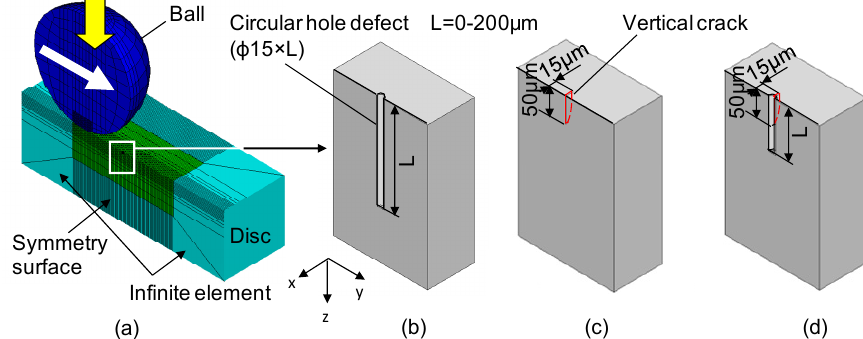
Figure 5: FE models for the RCF test. (a) Entire model. (b) Magnification of defect (without crack). (c) Vertical crack ( L =0 μ m). (d) Defect & vertical crack.